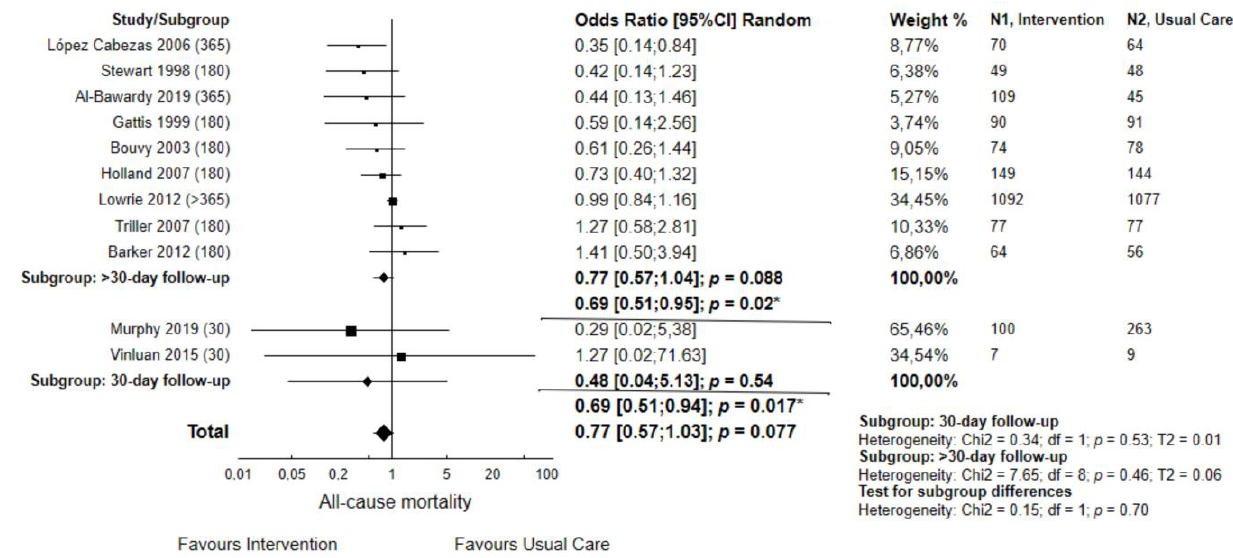
Figure 4. Forest plot of comparison: intervention vs. usual care for dichotomous data concerning mortality (odds ratio, OR) in studies where 100% of patients were hospitalized from heart failure- related conditions. Pharmacist-led interventions provided a slight reduction in mortality ( p = 0.077). Days of follow-up are shown in brackets. * Outcomes after removing one study according to the results of sensitivity analysis [3,18–20,23,25,26,33,43,44,47].